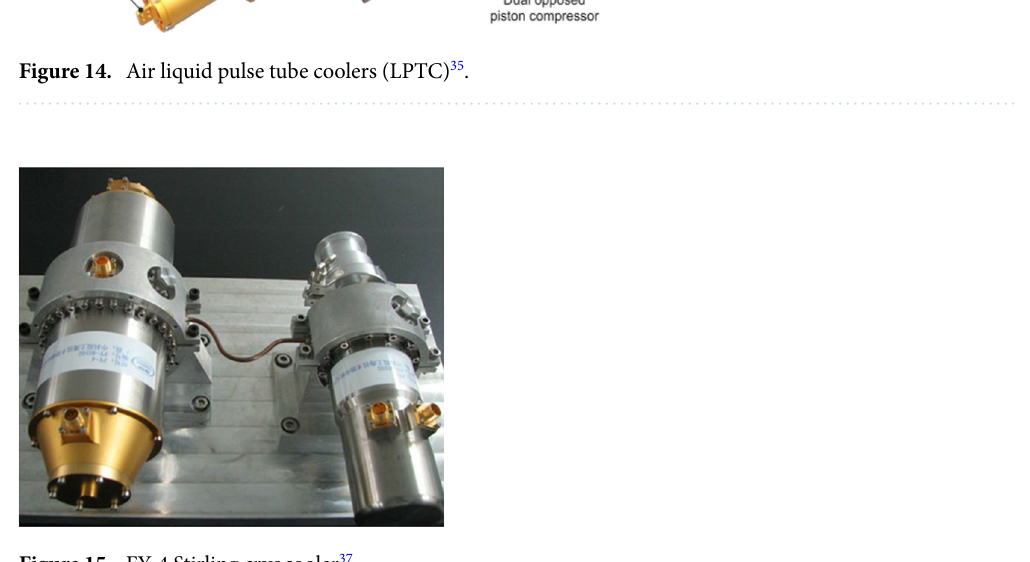
Figure 15. FY-4 Stirling cryocooler 37